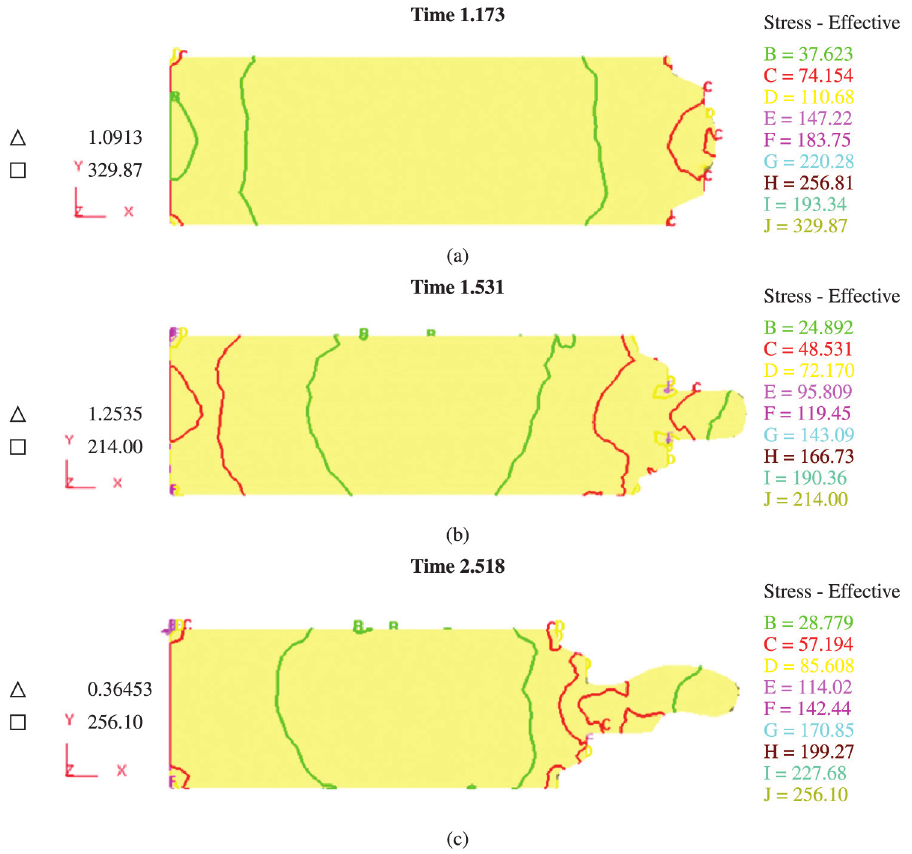
Figure 6. the evolutions of effective stress contours in Mg billet during different ES